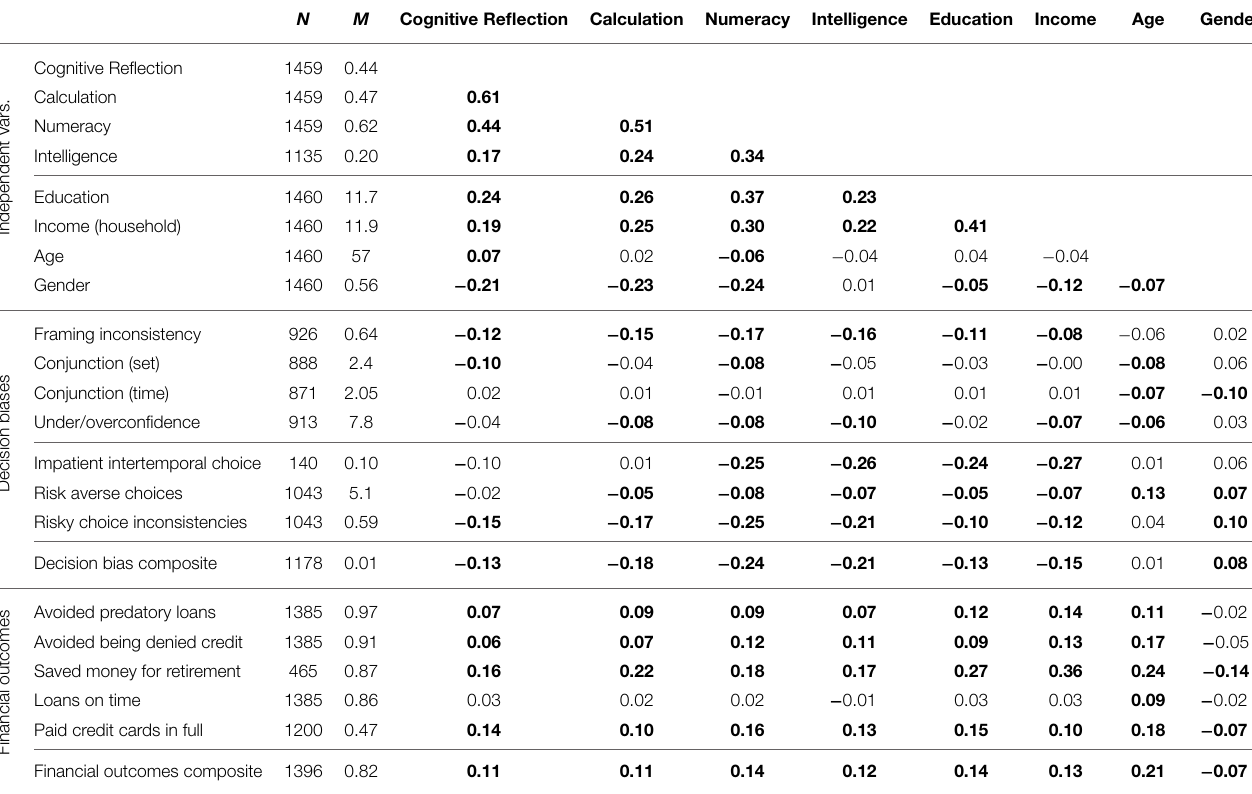
TABLE 7 | Correlations of independent measures among themselves and with dependent measures in Study 2. N M Cognitive Reflection Calculation Numeracy Intelligence Education